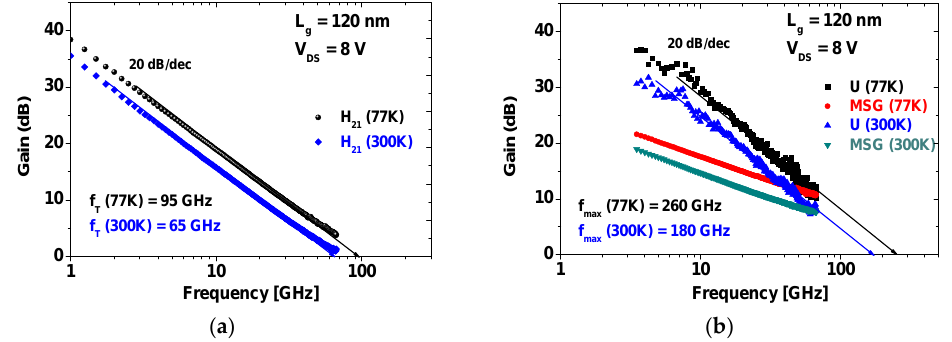
Figure 4. Current ‐ gain (Figure 4a) and power ‐ gain cut ‐ off frequency (Figure 4b) at V DS = 8 V of a 0.12 Figure 4. Current-gain (Figure 4a) and power-gain cut-off frequency (Figure 4b) at V DS = 8 V of a × 50 μ m² AlInGaN/GaN HEMTs at RT (in blue) and 77 K (in black). 0.12 ˆ 50 µ m 2 AlInGaN/GaN HEMTs at RT (in blue) and 77 K (in The increase in both f T and f max at 77 K is in good agreement with the transfer characteristics in Figure 3 as well as the studies reporting on low temperature behavior of GaN ‐ based HEMTs in the literature [15,16]. It can be pointed out that RF performances are mainly limited by the access resistances due to rather high parasitic contact resistances.